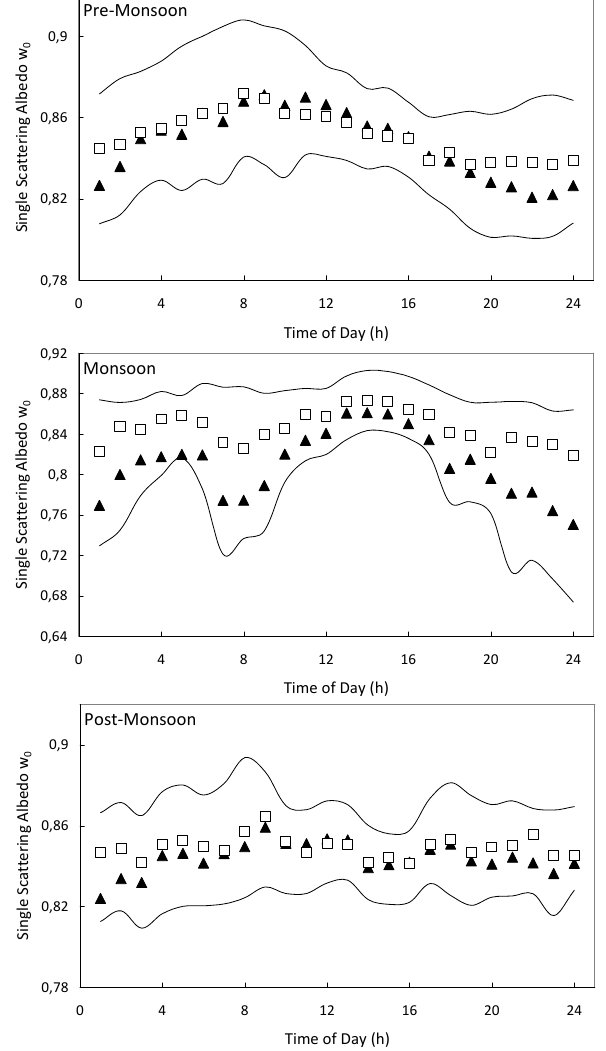
Fig. 4. Diurnal variability of the hourly averaged (square) and me- dian (triangle) single scattering albedo values at NCO-P for pre- monsoon, monsoon and post-monsoon periods. Dashed lines repre- sent 25 and 75-percentile, respectively.